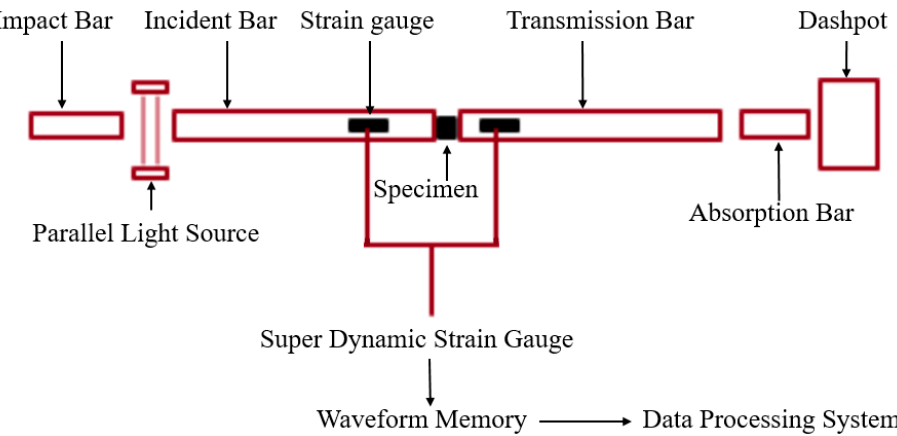
Figure 2. Schematic diagram of SHPB experimental